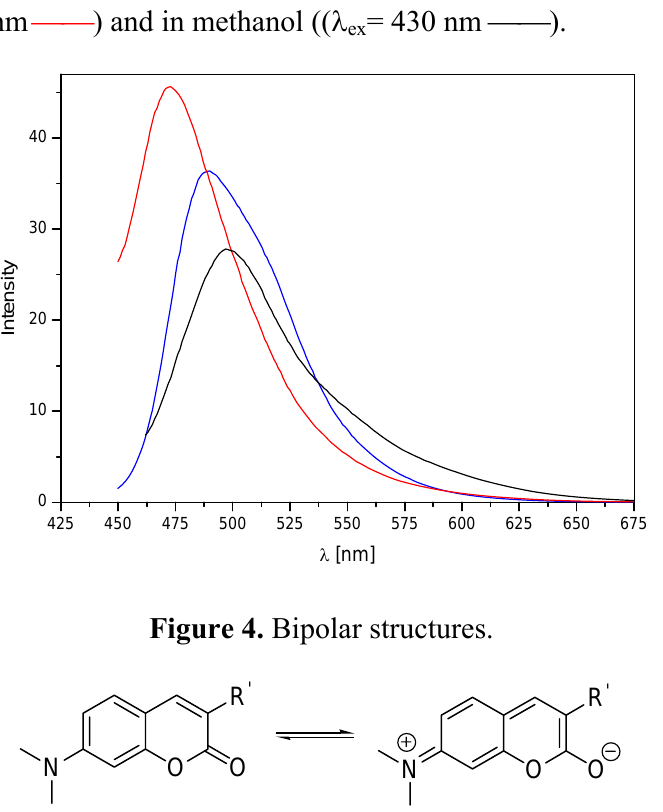
Figure 3. Fluorescence emission spectra of 4c in toluene ( λ toluene ( λ = 430 nm ⎯⎯ ) and in methanol (( λ ex